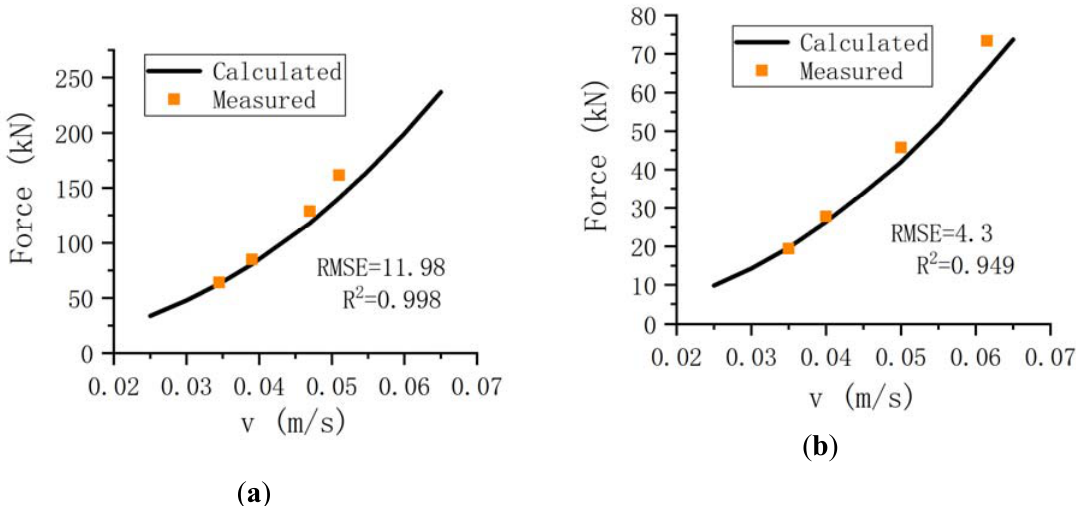
Figure 7. Comparison of experimentally measured results (converted to prototype results) and simulation ‐ calculated values: ( a ) water blocking rate of 0.82; ( b ) water blocking rate of 0.716.